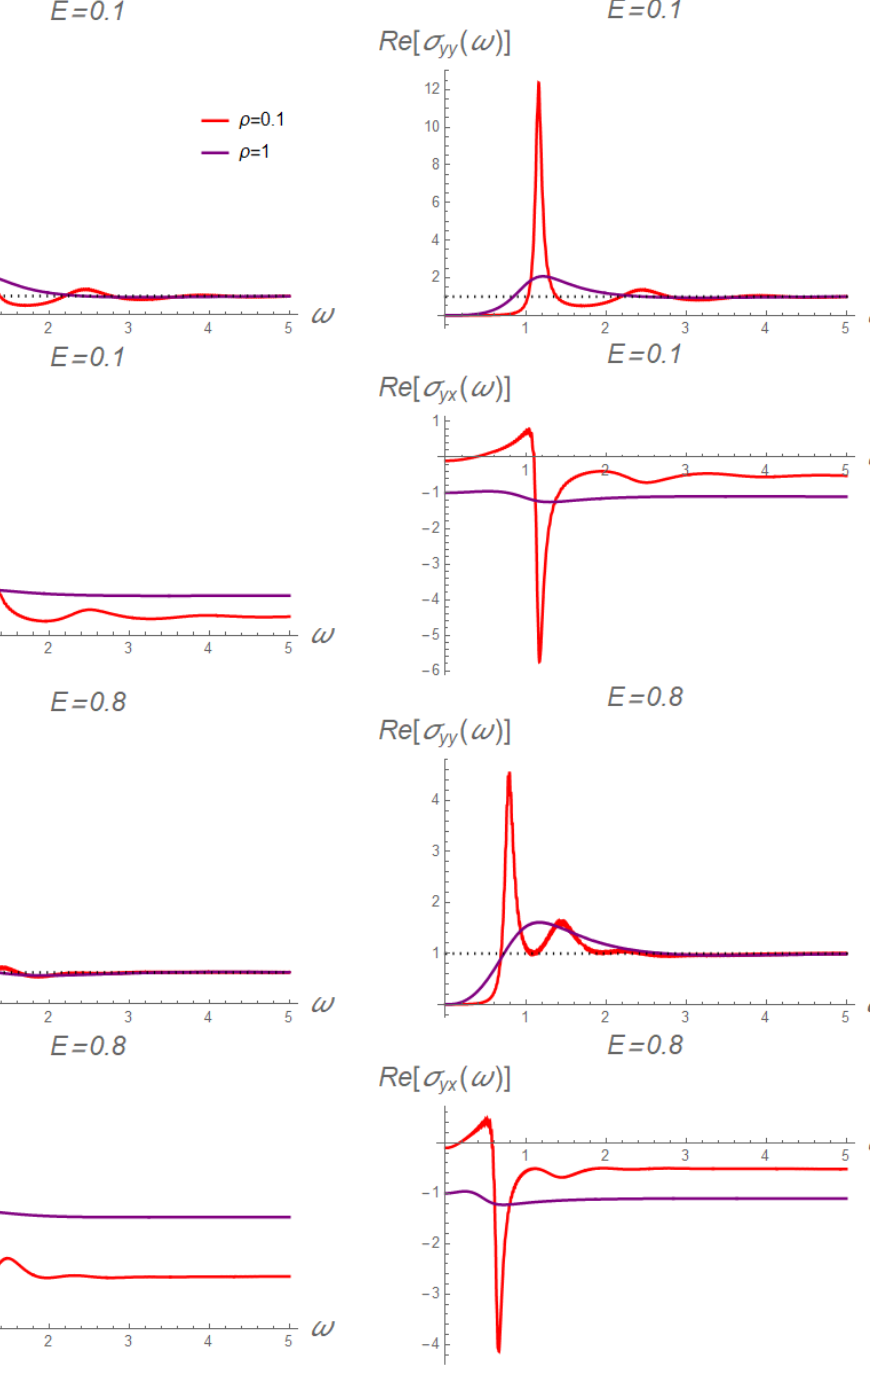
Figure 7 . Real parts of the conductivities for di(cid:11)erent values of electric (cid:12)eld E and charge density (cid:26) in the case E < B (non-symmetric phase).